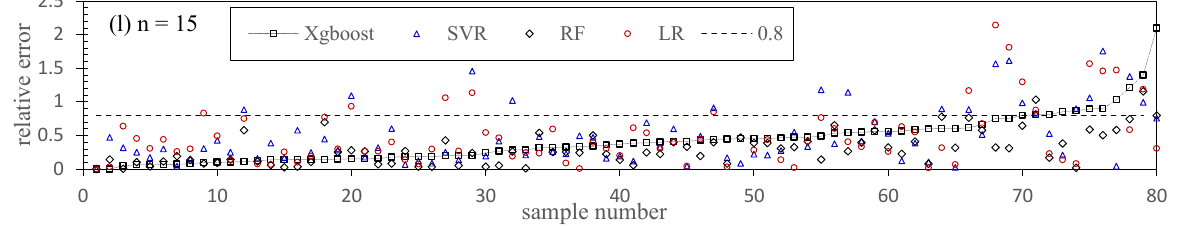
Figure 6. Relative error of the Chl- a for each sample point. ( a ): n = 4; ( b1 , b2 ): n = 5; ( c ): n = 6; ( d ): n